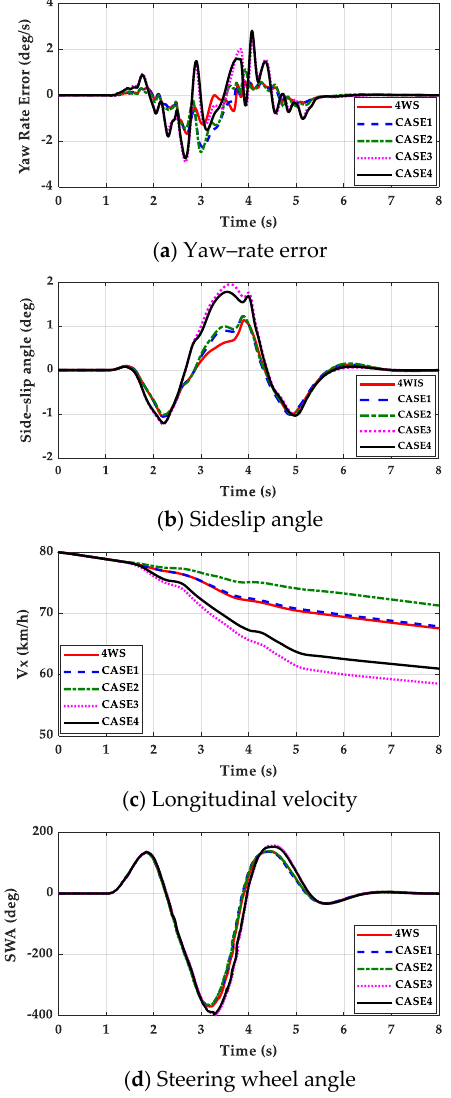
Figure 7. Simulation results for each case.